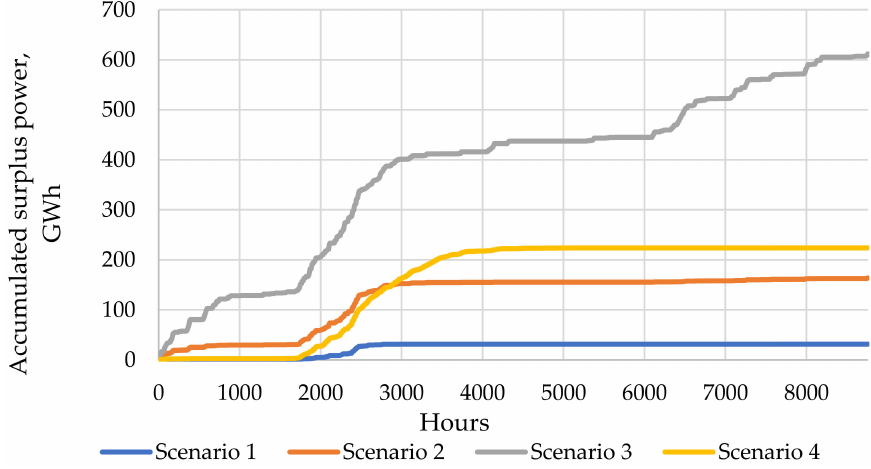
Figure 15. Accumulated surplus